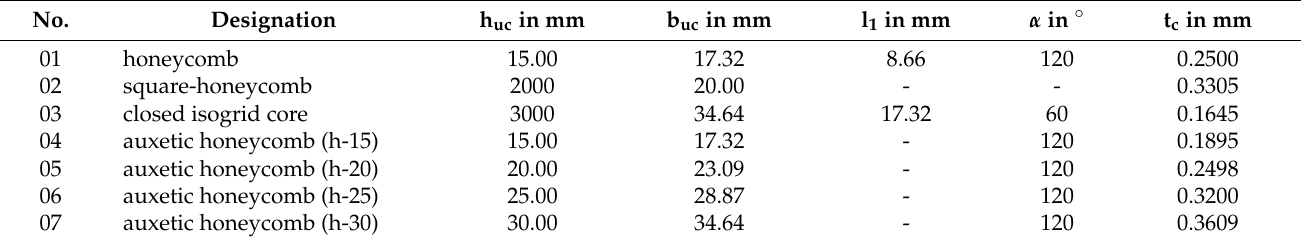
Table 1. Topology and parameters: closed prismatic honeycomb cores. See Figure 3.